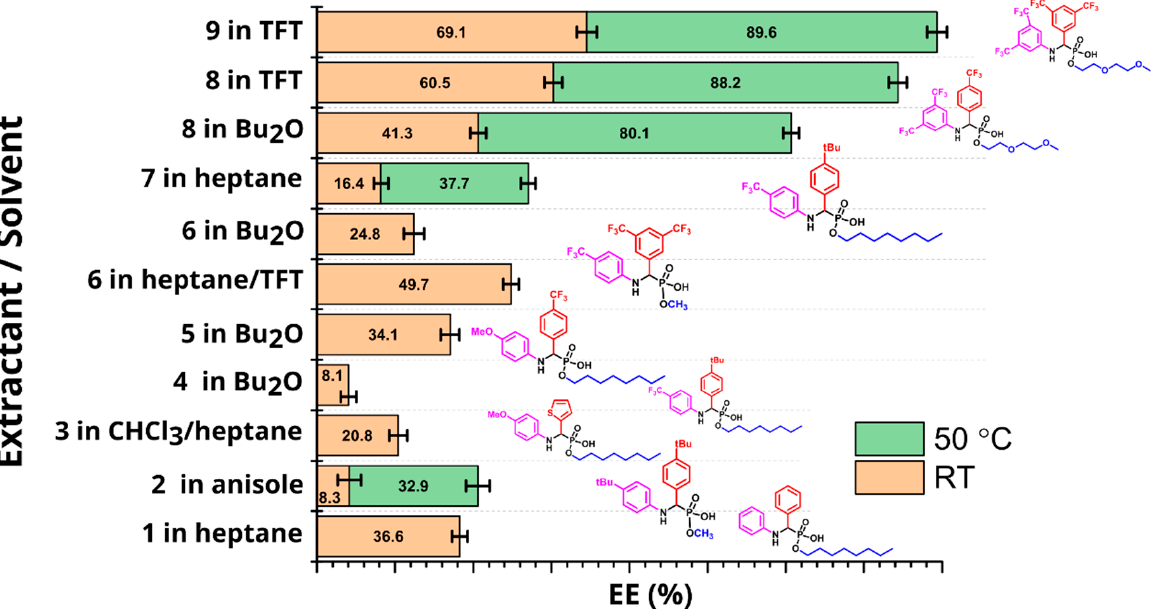
Figure 3. LLE of 68 Ga using extractants 1–9 in batch. In each case, the solvent system was chosen in such a way as to provide the best solubility and phase separation for a given extractant. Table 2. Batch LLE optimization studies using the central composite face-centered design algorithm implemented in MODDE 9.1.1. Concentration and the temperature were simultaneously varied.